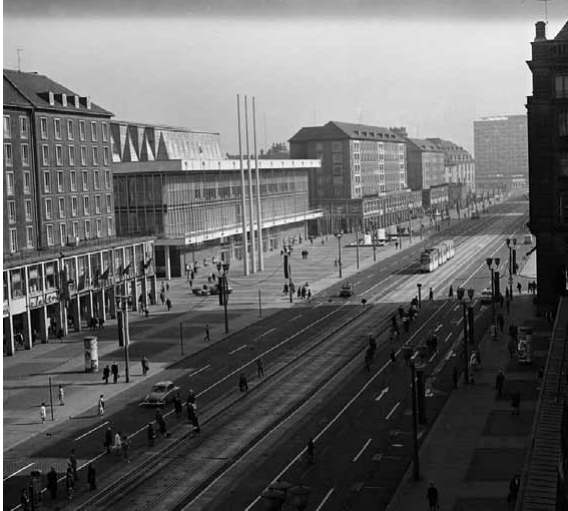
fig. 4. Kulturpalast Dresden . View from the Wilsdruffer Straße, around 1971. SluB Dresden / Deutsche fotothek / Erich